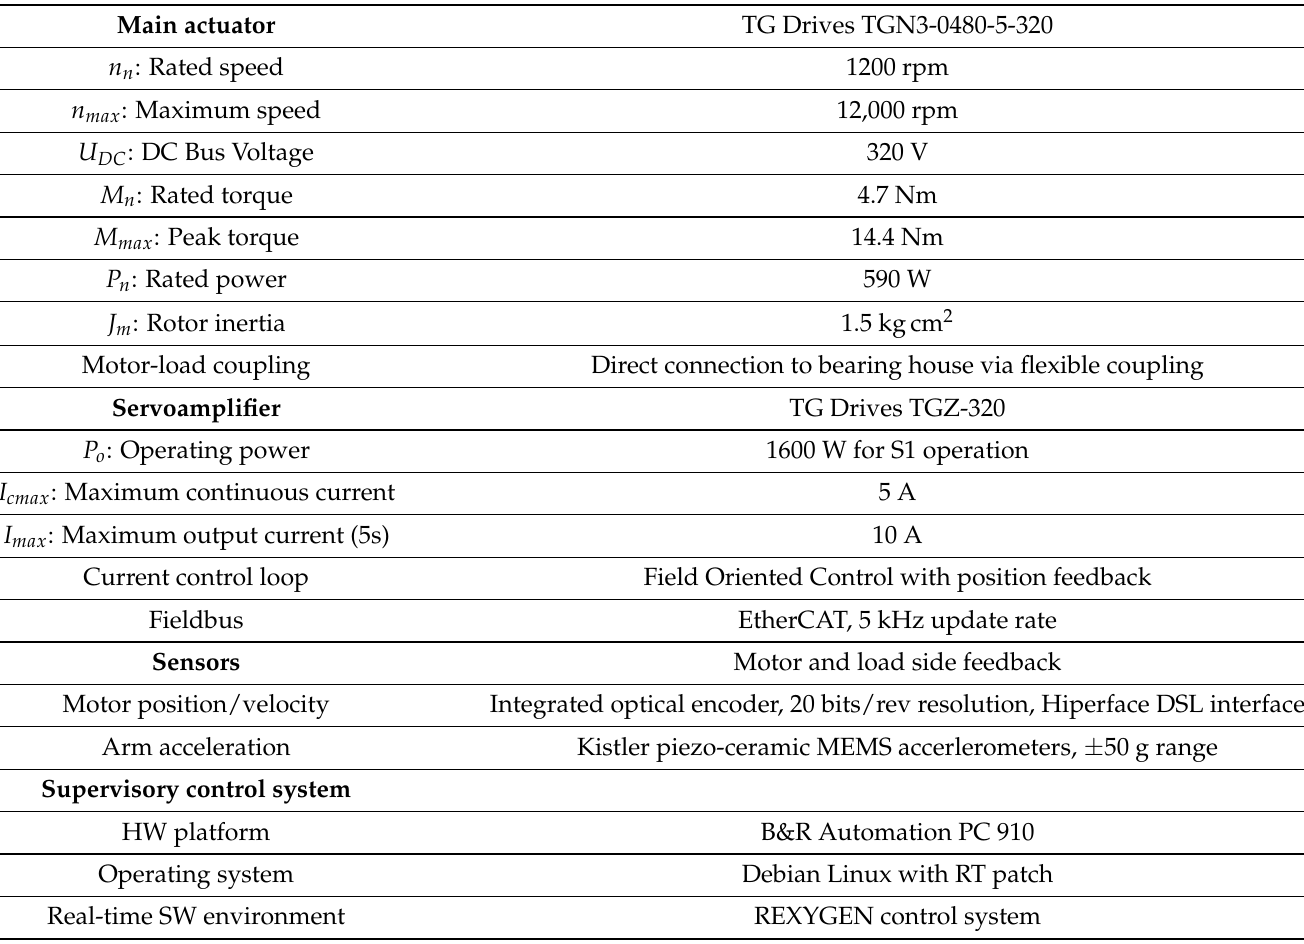
Table 1. Drive, sensors and control system parameters.